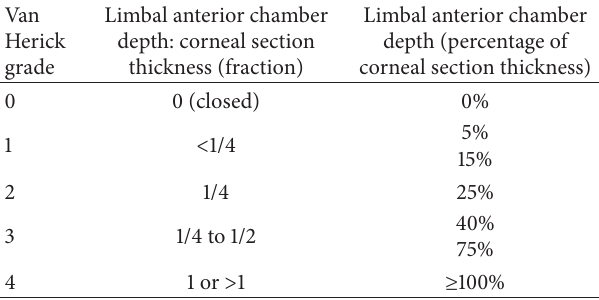
Table 1: Limbal anterior chamber depth grading